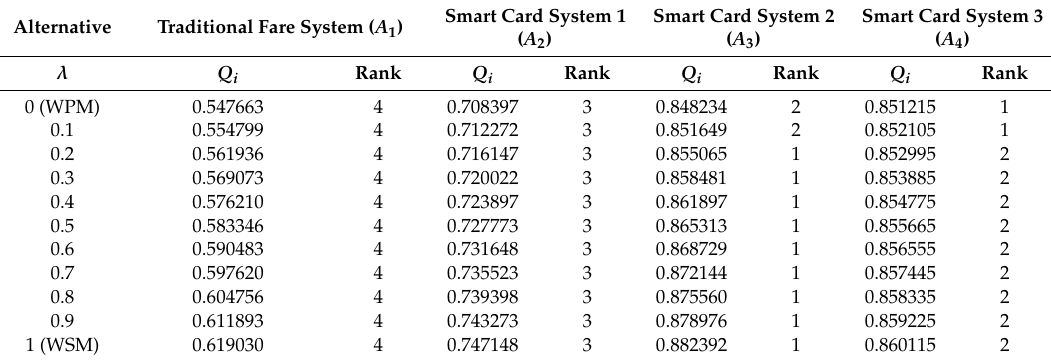
Table 8. Weighted aggregation results of WASPAS